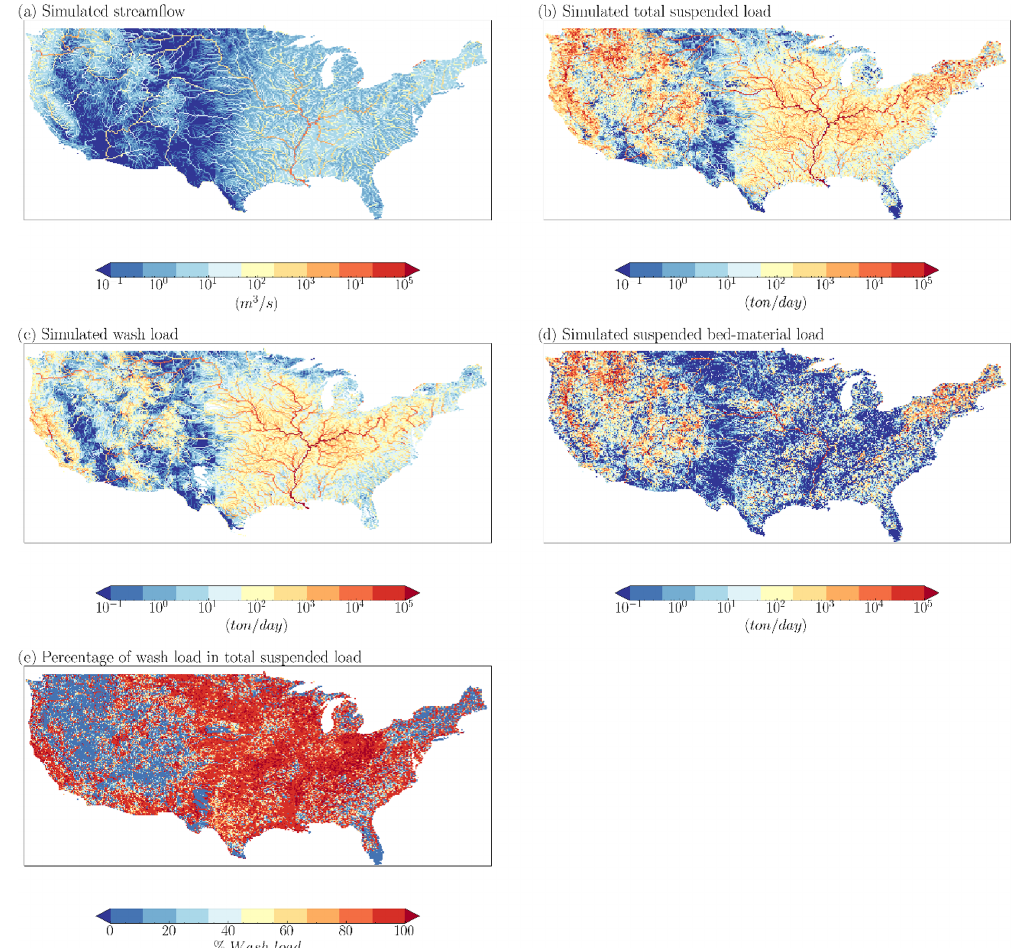
Figure 4. Spatial maps of simulated streamflow, total suspended load, wash load, and suspended bed-material load averaged in